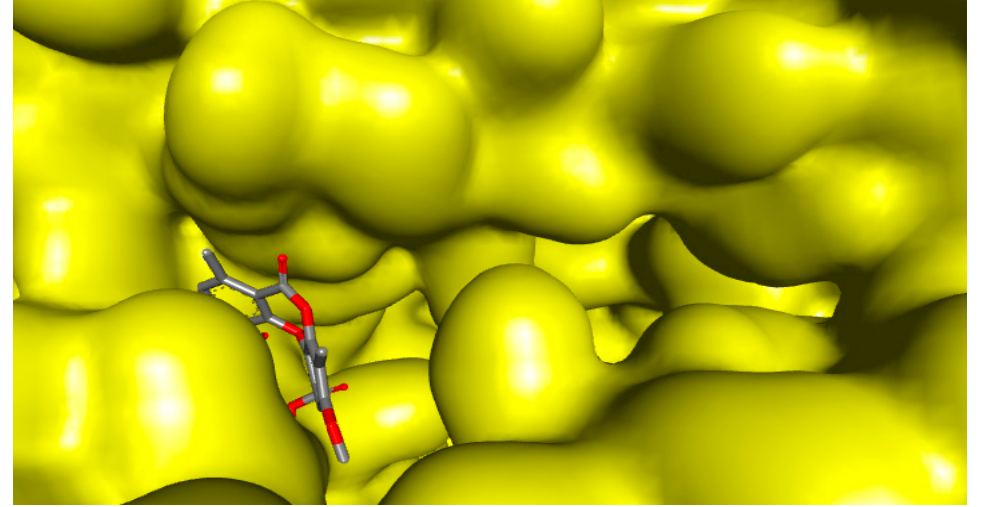
Figure 3. Molecular surface depiction of HSV-2 protease. As shown, psoromic acid binds remarkably to the active site of the enzyme.